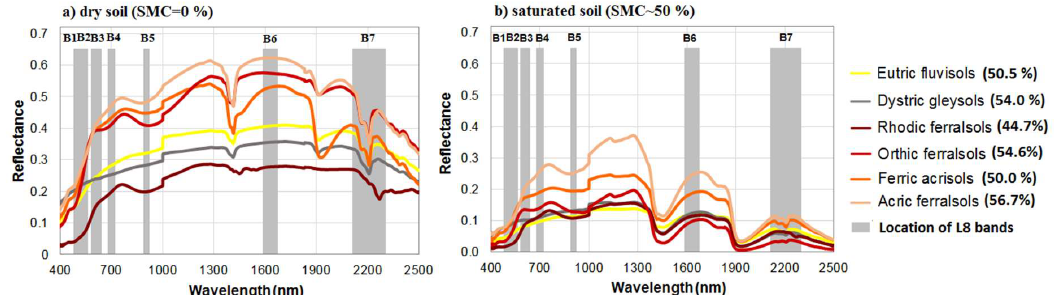
Figure 3. Spectral features of dry soil (SMC = 0%) and saturated soil (SMC ~ 51.9%) of six investigated soil types laid over the band locations of the L8 multispectral bands. The difference of soil reflectance, R rs ( λ ), at both soil states, (a) dry and (b) saturation, indicates the effect of not only the SMC, but also other soil components on R rs ( λ ).